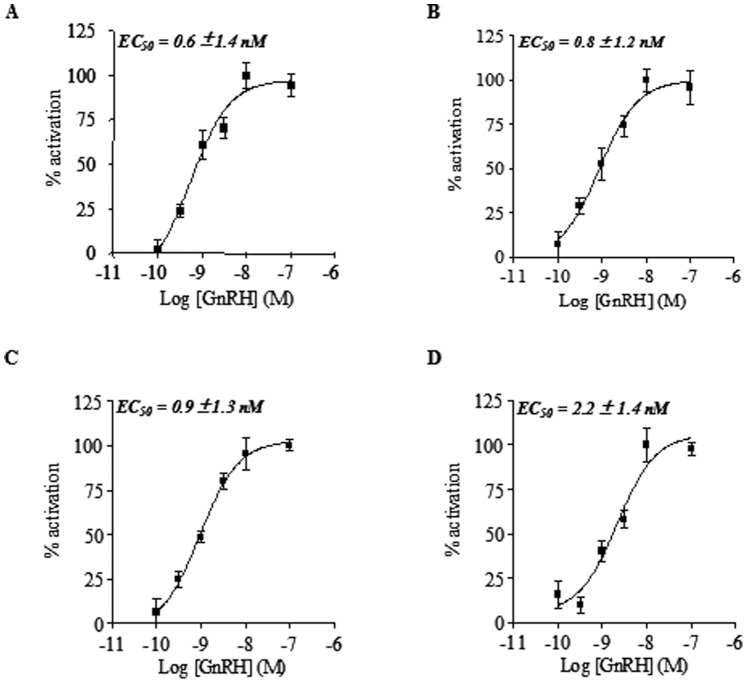
Concentration-dependent effect of GnRH.Concentration-dependent enhancement of CFTR’s function by GnRH in 16HBE14o− (A), CFBE41o− (B), CFBE41o−/corr (C) and CFBE41o−/F508del (D): CFTR activity was assessed with the iodide effluxes technique in the presence of forskoline (10 µM) plus genistein (30 µM) after 1h of incubation. Results are expressed as normalized means (± SEM, n = 4).